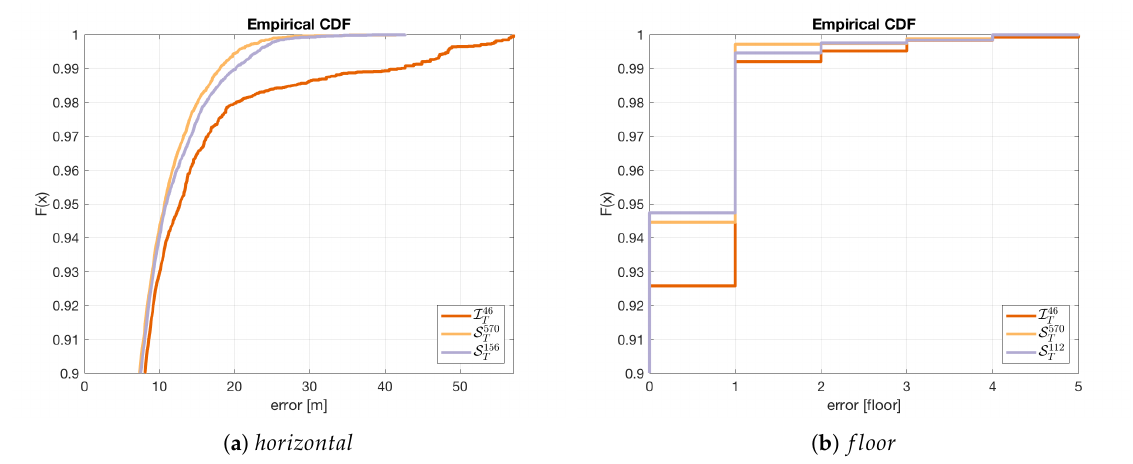
Figure 9. The comparison of the errors µ E h and ε f obtained for localisation system working on three different sets of